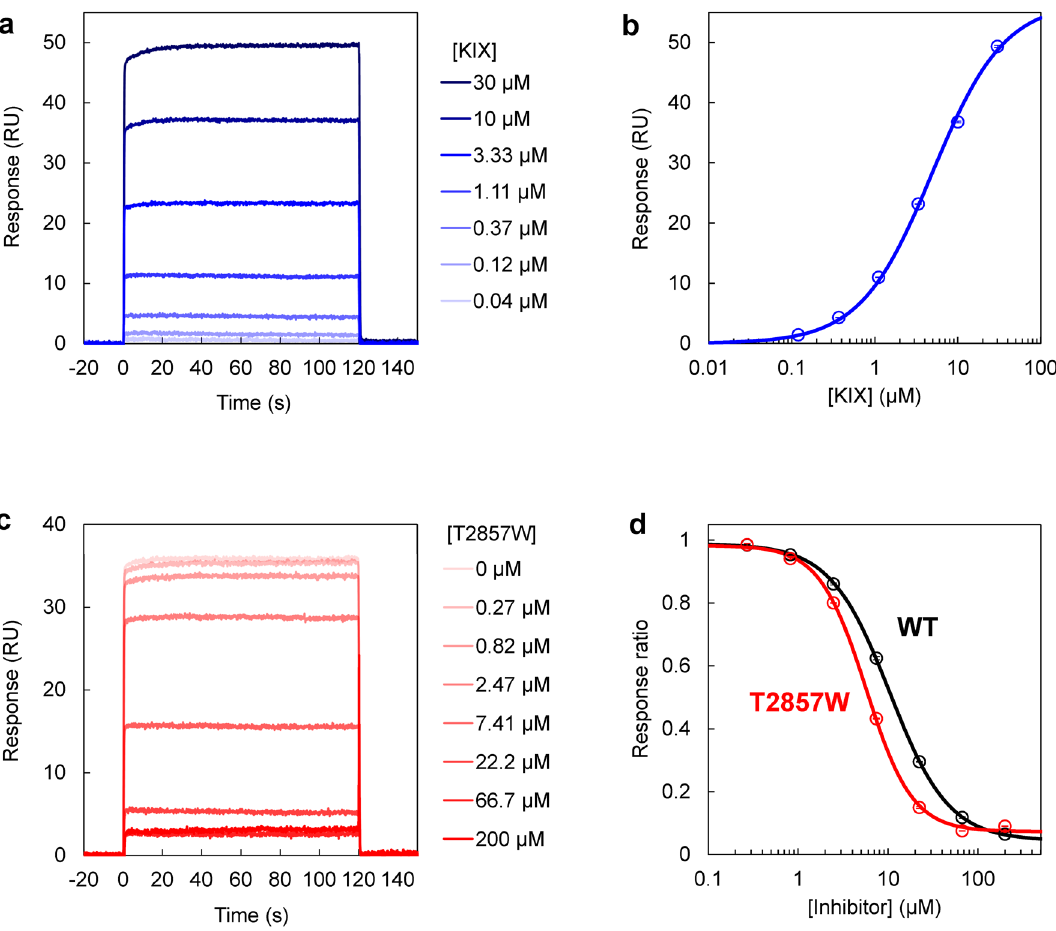
Figure 5. Competitive inhibition assay using surface plasmon resonance. ( a ) The sensorgrams of KIX binding to the immobilized MLL TAD. The KIX concentrations are shown. ( b ) The titration curve of the KIX binding to the immobilized MLL TAD. The continuous line was obtained by fitting to Eq. (4). ( c ) The sensorgrams of KIX binding to the immobilized MLL TAD in the presence of the designed T2857W peptide. The peptide concentrations are shown. The KIX concentration was 5 μM. ( d ) Inhibition of KIX binding to the immobilized MLL TAD by an increasing concentration of an inhibitor (the wild type [WT] and T2857W mutant of the MLL TAD peptide). The IC 50 value was 10.4 ± 0.2 μM for WT and 5.67 ± 0.01 μM for the T2857W mutant. In ( b ) and ( d ), the mean and standard error of triplicate measurements are shown. The figures were created with